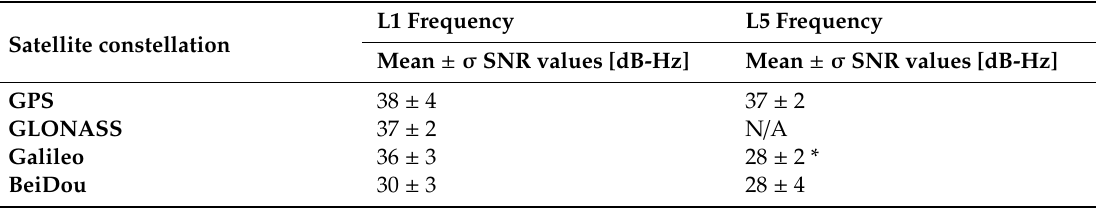
Table 2. Main statistics parameters of collected signals from smartphone devices considering di ff erent GNSS constellations.